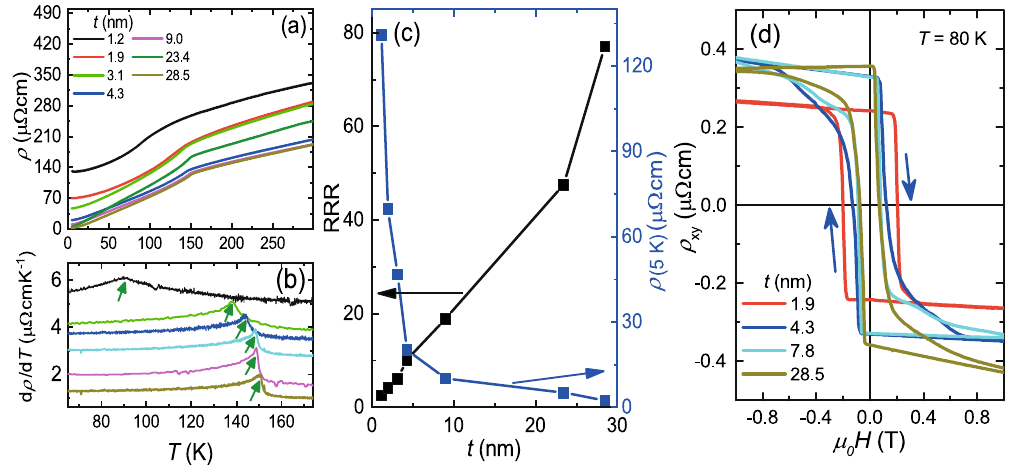
Figure 6. Transport data of SRO( t ) films on STO. ( a ) Temperature dependent resistivity in SRO films with different t values. ( b ) Derivative of the ρ( T ) curves for different t values, where the peak corresponds to the T c . ( c ) Variation of RRR and ρ (5 K), extracted from the ρ( T ) , as a function of t . ( d ) The Hall resistivity as a function of magnetic field for different t values at T = 80 K. The presence of hysteresis loops indicates the ferromagnetic nature of the SRO films on